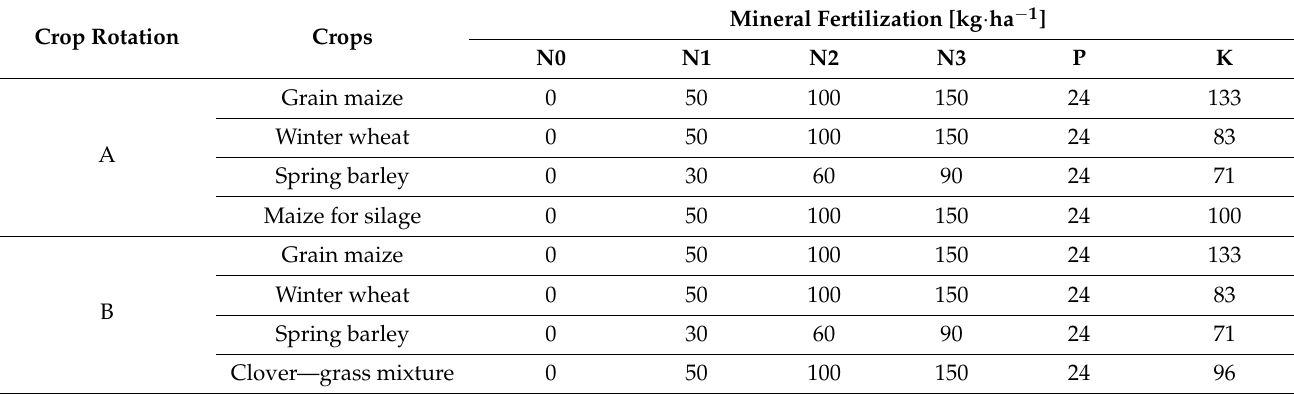
Table 1. Mineral fertilization for crop rotation A and